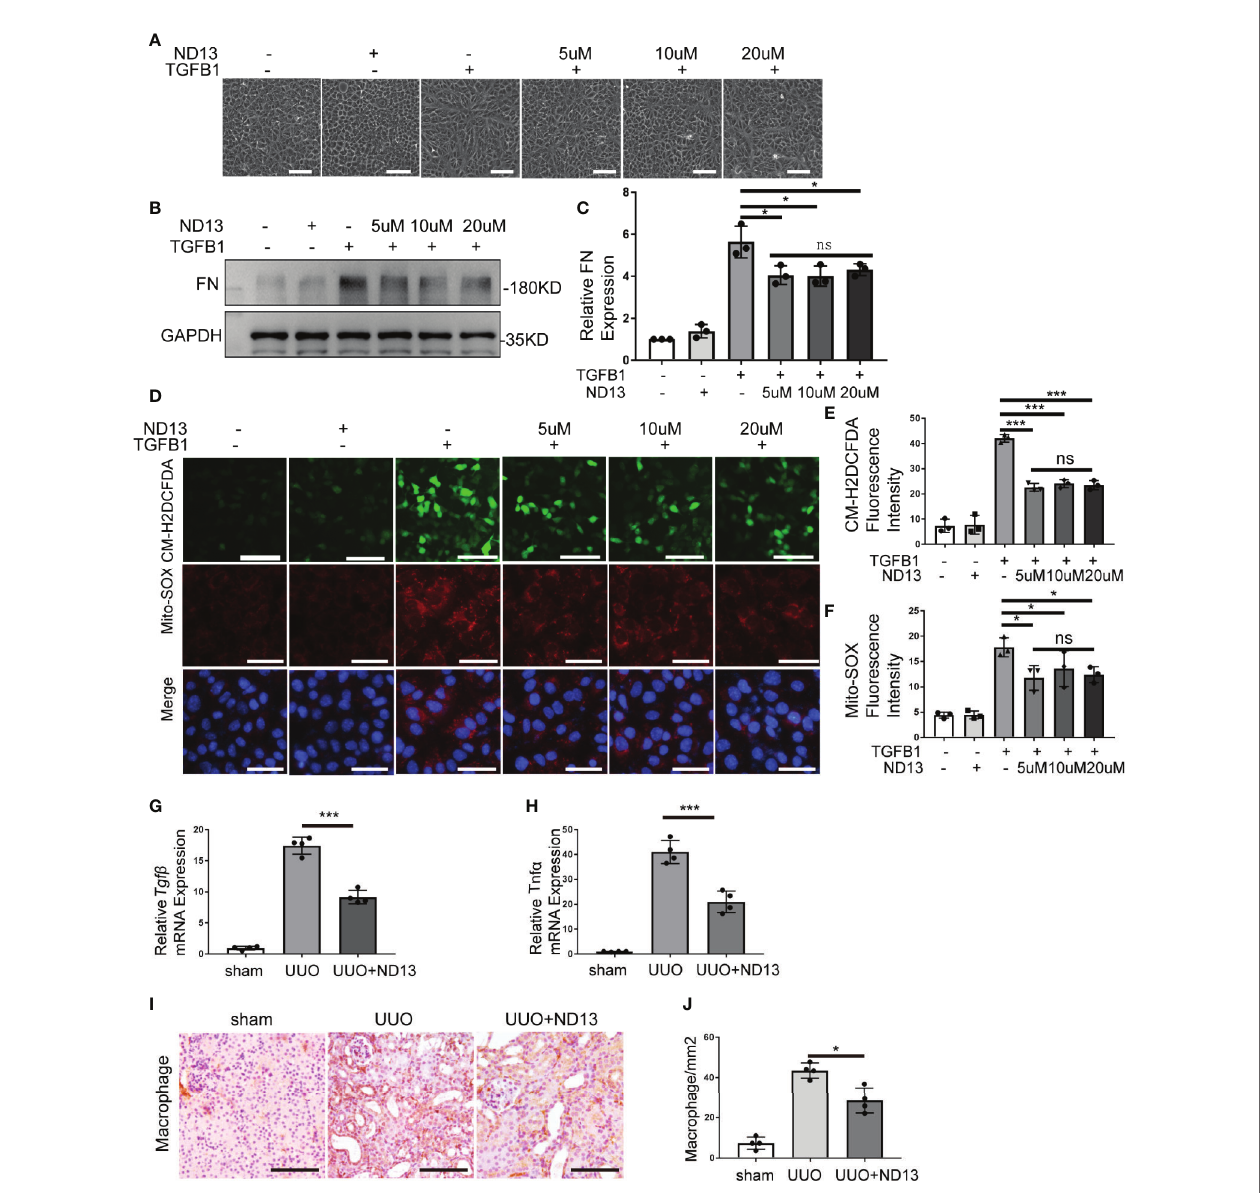
FIGURE 8 | ND-13 attenuates TGFB1-induced fi brosis changes in BUMPT cells. (A – F) BUMPT cells were cultured in medium with/without 5ng/ml TGFB1 in the presence/absence of ND13 for 24 hours. (A) Representative images of cell morphology. Bar: 100 m m. (B) Representative immunoblot of Fibronectin (FN), GAPDH (protein loading control). (C) Densitometry of FN (n=3). The signal of FN was normalized to the GAPDH signal of the same samples to determine the ratios. The values are expressed as fold change over control cells. (D) Representative images of CM-H2DCFDA and Mito-SOX staining. Bar: 100 m m in the CM-H2DCFDA image, 50 m m in the Mito-SOX and Merge images. CM-H2DCFDA and Mito-SOX staining was performed to evaluate intracellular and mitochondrial ROS, respectively. (E, F) Quanti fi cation of CM-H2DCFDA and Mito-SOX fl uorescence intensity (n=3). (G – J) C57BL/6 mice (female, 8weeks old) were subjected to sham operation or UUO surgery. Administration of ND-13 (2 mg/kg of body weight) via tail veil injection starting from the day of surgery and daily thereafter. The mice were euthanized at 7 days after surgery, and the UUO-obstructed kidneys were collected. (G, H) mRNA levels of transforming growth factor- b ( Tgf b ) and tumor necrosis factor alpha ( Tnf a ) were measured by quantitative RT-PCR. (I) Representative images of macrophage staining. Bar: 100 m m. (J) Quanti fi cation of macrophage -positive cells (n=4). Each symbol (circle, diamond and trigon) represents an independent experiment. Error bars: SEM. *p < 0.05, ***p < 0.001, ns not signi fi